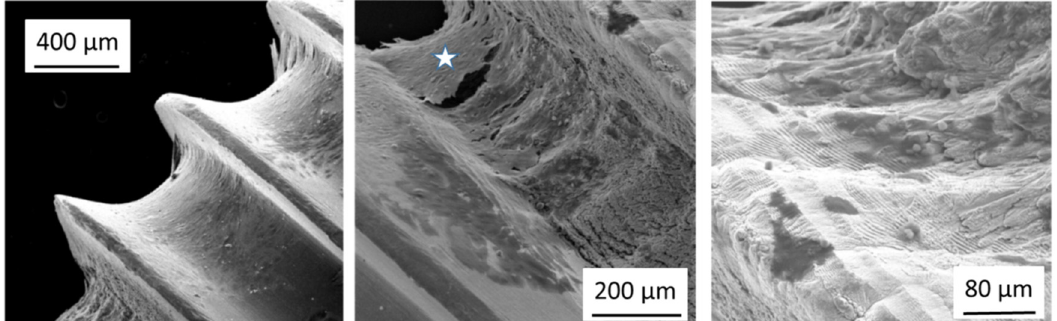
Figure 3. SEM image comparison of a pre-anodized titanium-based bone screw without femtosecond laser treatment ( left ) showing osteoblast growth and adhesion, and the same screw with femtosecond laser treatment ( middle ) showing cell-free areas, and details at higher magnification ( right ). Adapted from [86].